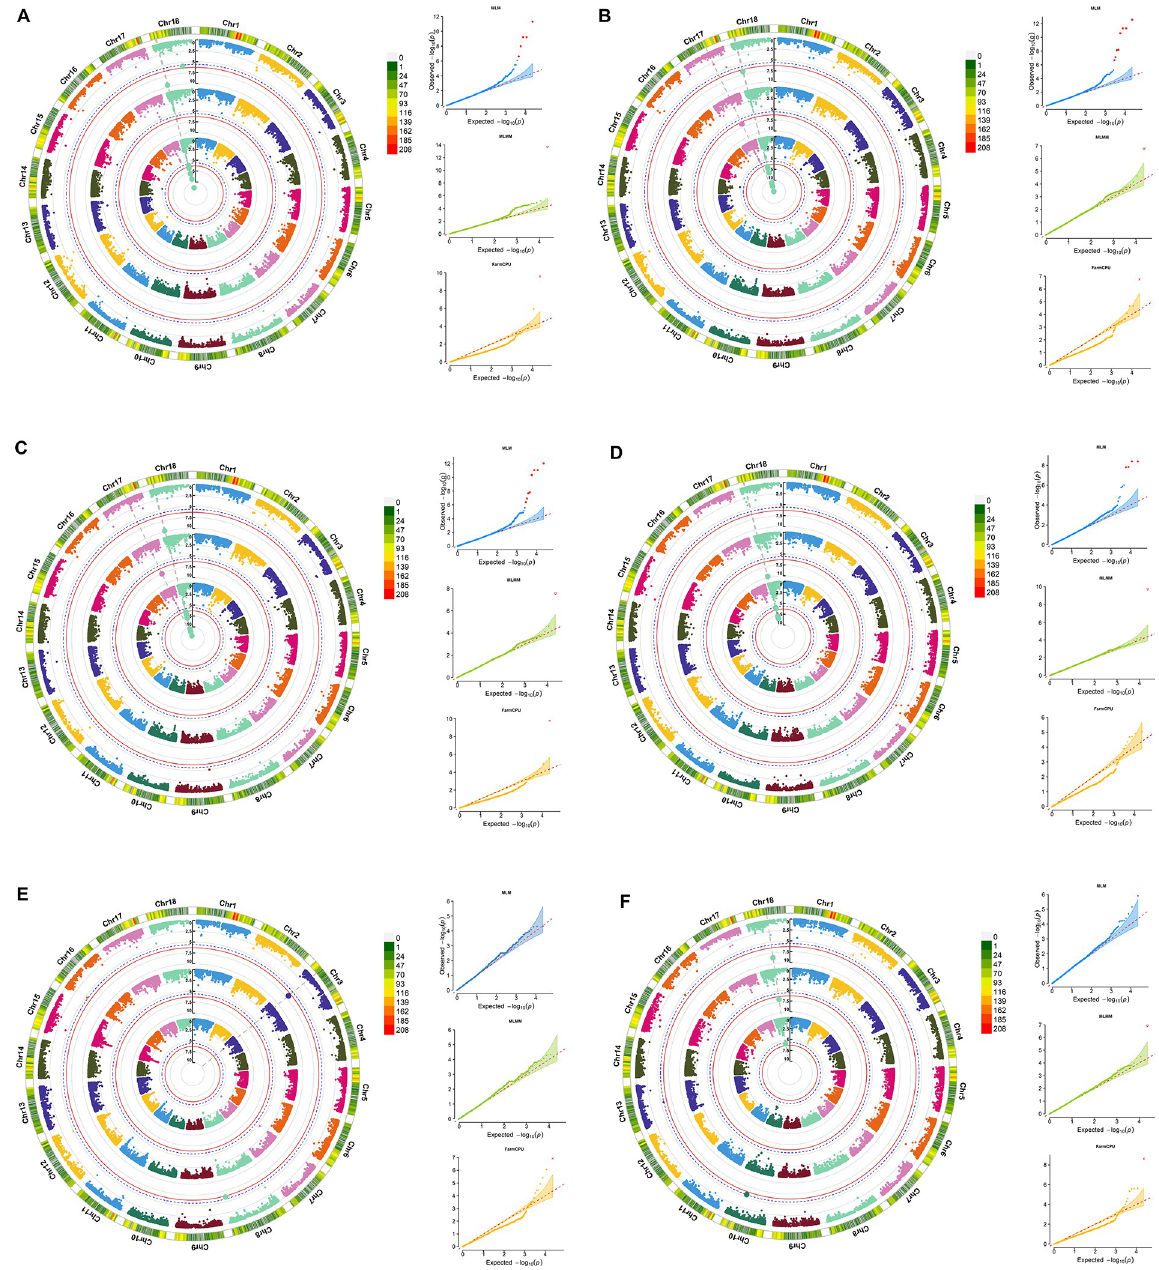
Fig 4. Circular Manhattan plot indicating the single-nucleotide polymorphisms (SNPs) associated with (A) setback, (B) final viscosity, (C) cool paste viscosity, (D) hot paste viscosity, (E) pasting temperature, and (F) peak viscosity, by analyzing the pasting properties of starch from a set of 876 cassava accessions. The locations of SNPs on the chromosome and the association test (-log 10 (p)) are plotted on the x-axis and y-axis, respectively. The blue dotted line and red line indicates the Bonferroni correction at p < 0.05 and p < 0.01, respectively. The chart (right) presents the quantile-quantile (QQ) plot of the observed and expected p -values from association analyses based on the mixed linear model (MLM), multi-locus mixed model (MLMM), and fixed and random effects model for circulating probability unification (FarmCPU)